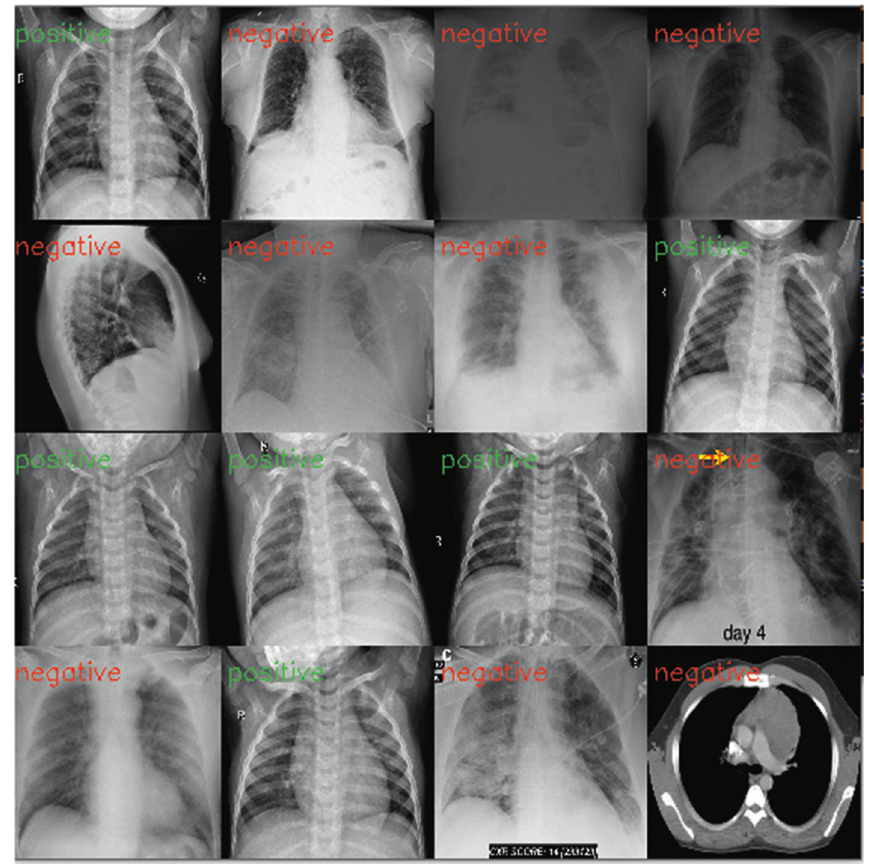
Figure 11: Tested VGG19 model.